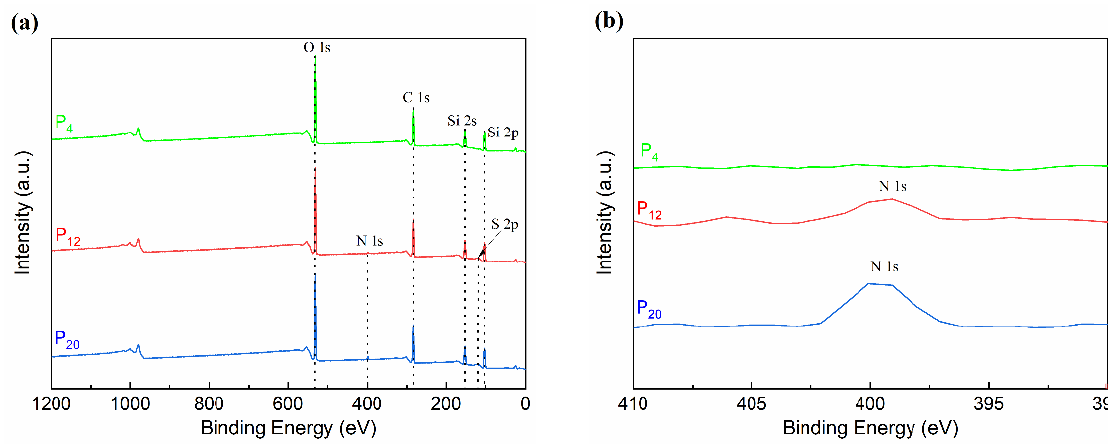
Figure 5. ( a ) XPS spectra; ( b ) locally amplified spectra.